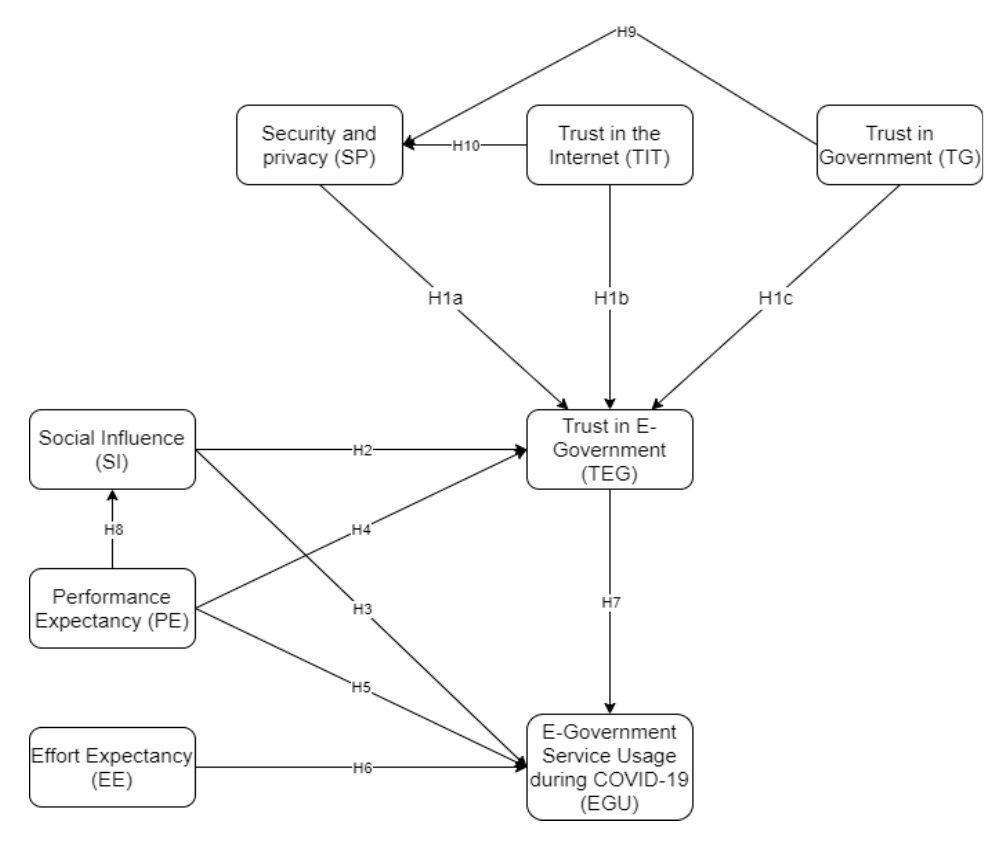
Figure 1. Research